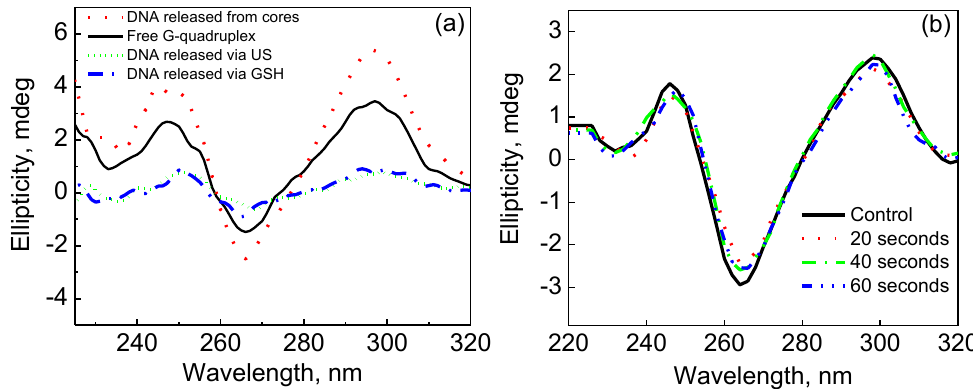
Figure 7. CD spectra of free G-quadruplex oligonucleotides (solid black) after encapsulation and release from the CaCO 3 cores via dissolution in EDTA (dot red) or after release from the (PMAA/PVPON) 13 capsules via degradation by GSH (dash dot blue) or 22 kHz ultrasound (55 W/cm 2 for 20 s) (short dot green). G-quadruplex oligonucleotides (solid black) were exposed to 22 kHz ultrasound (55 W/cm 2 ) for various times and measured for retention of secondary structure.